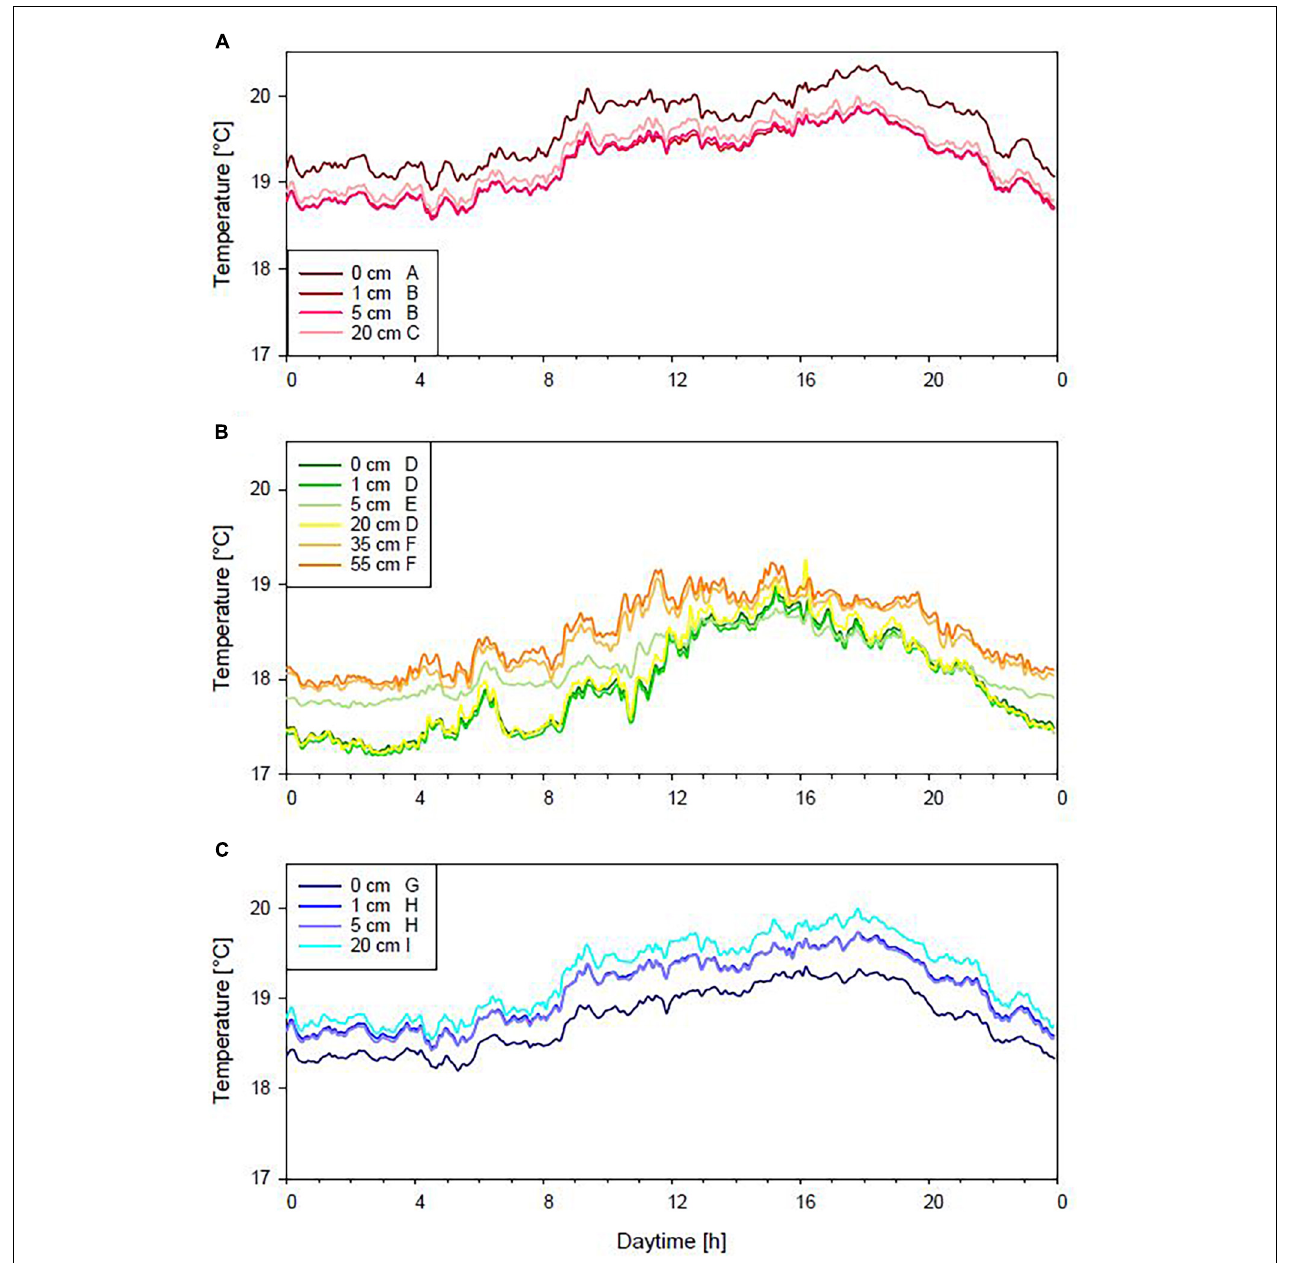
FIGURE 2 | Average temperature in Phyllophora crispa (A) , Posidonia oceanica (B) and on rocky substrates (C) . Displayed are mean values. No differences are indicated by the same letter, significant differences by different